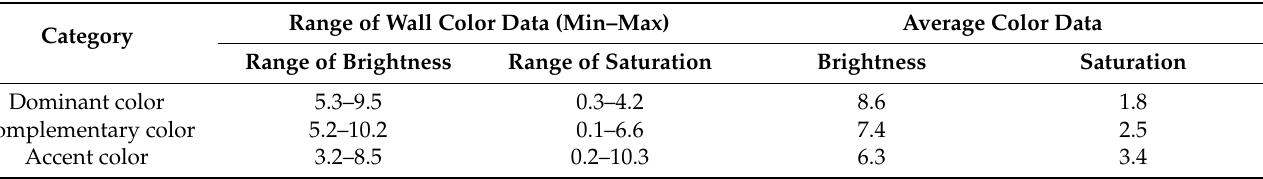
Table 5. Data analysis of environmental colors in public health facilities.